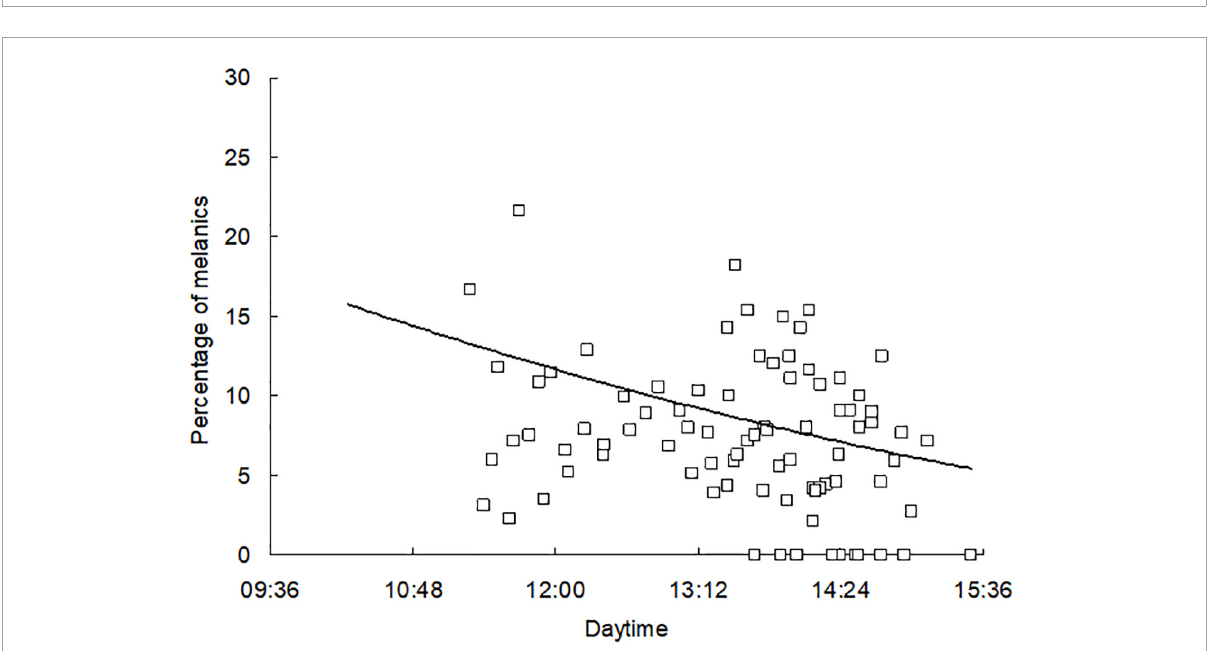
FIGURE4 Flight activity of the color forms of adults migrating to overwintering sites; aggregate data from 2013 to 2021. Individual symbols indicate the percentage of melanic adult Pm in samples of adults arriving at the building facade at 15-min intervals on days of mass flight to overwintering sites (shaded symbols in Figure 2 ). Three values highly exceeding 30% are not shown. The data were fitted by the second-order polynomial y = 60.36x 2 –112.04x + 52.60, N = 89, R 2 = 0.0476, P = 0.050.